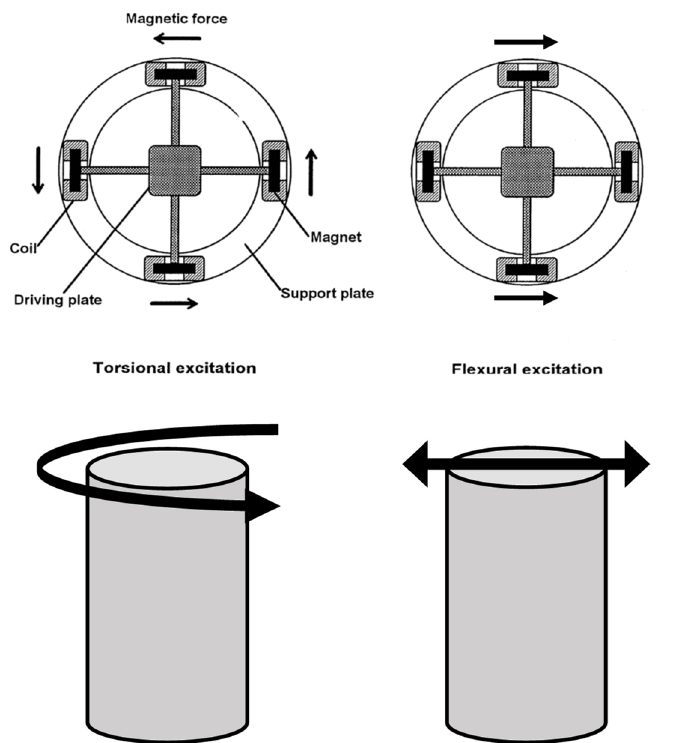
Figure 1. Resonant column torsional and flexural test mode.